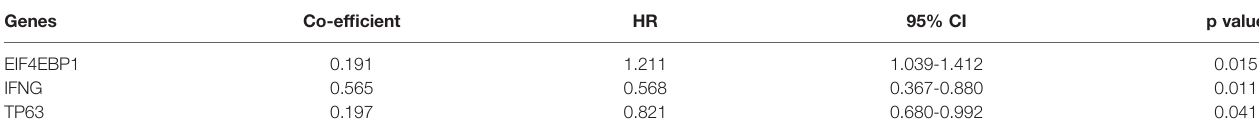
TABLE 2 | Multivariate cox regression analysis identi fi ed 3 ARGs that are independent factors for BC risks.